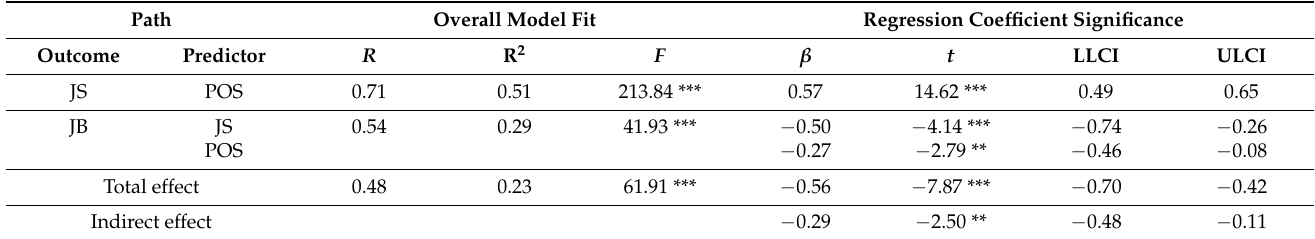
Table 8. Results of the mediating effect of job satisfaction on the relationship between perceived organizational support and job